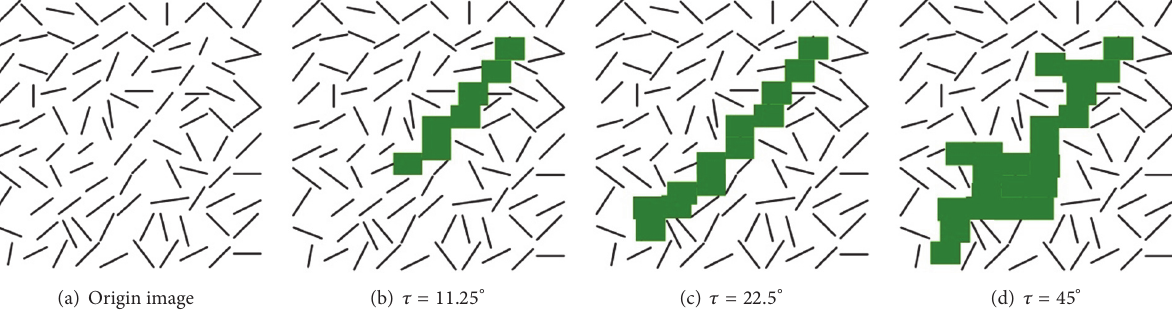
Figure 6: Region growing results with different 𝜏 . (a) is the original gradient map, including the edge area with noise interference. (b), (c), and (d) are results corresponding to 11.25 ∘ , 22.5 ∘ , and 45 ∘ , respectively.